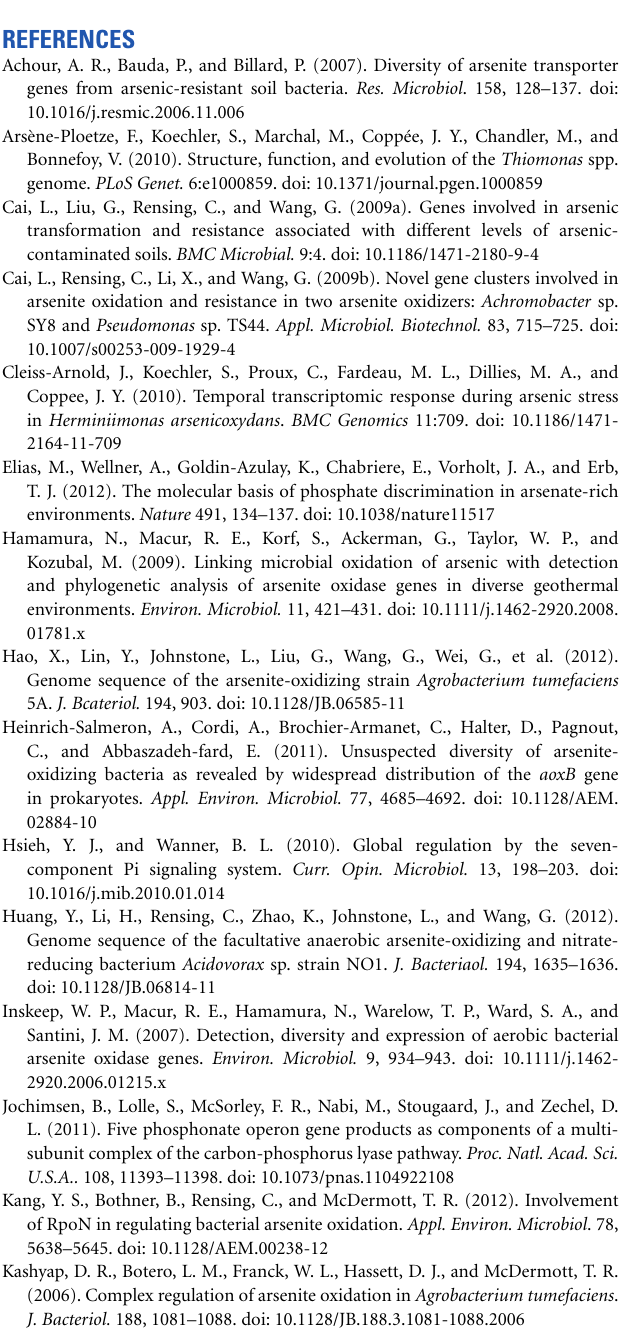
Supplementary Figure S3 |Phylogenetic trees based on PstS2 and 16S rDNA sequences. Bold and ∗ symbol represent proteins from the strains of the arsenic islands while the others are not. Phylogenetic relationship have been compared based on the inconsistency of the amino acid sequence tree (on the left) and the 16S rDNA tree (on the right). Supplementary Figure S4 |Phylogenetic trees of PhnC2 and 16S rDNA sequences. Bold and ∗ symbol represent proteins from the strains of the arsenic islands while the others are not. Phylogenetic relationship have been compared based on the amino acid sequence tree (on the left) and the16S rDNA tree (on the